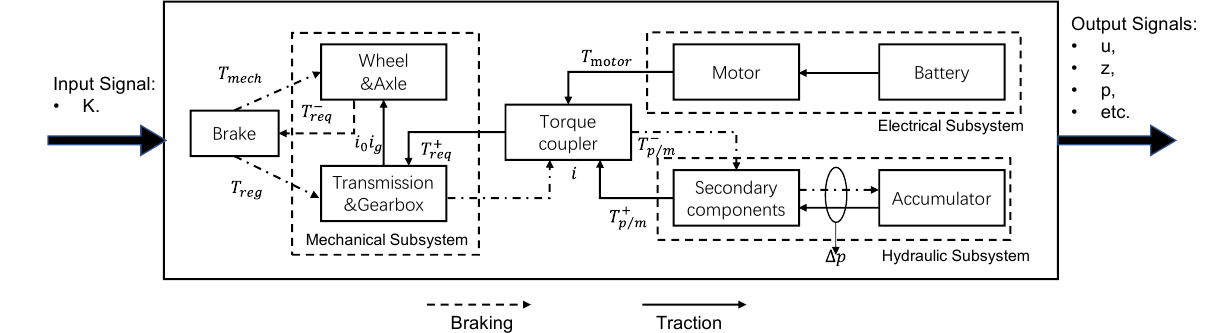
Figure 8. Torque flow of the parallel hydraulic regenerative braking system.